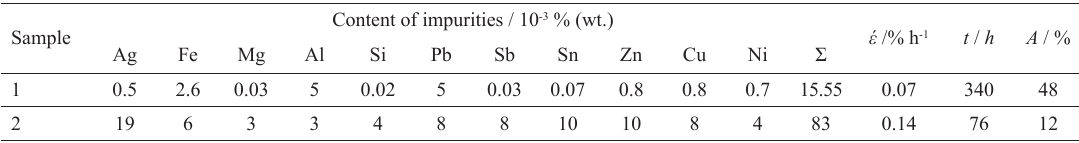
Table 6: The characteristics of high temperature resistance of alloy PtRh20Pd10Ir0.1Au0.1 depending on the total content of impurities